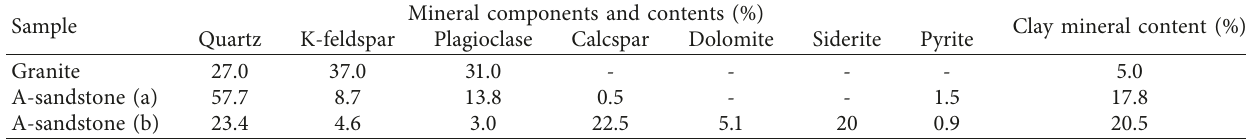
Table 2: Microcomponents of the samples by X-ray diffraction analysis.